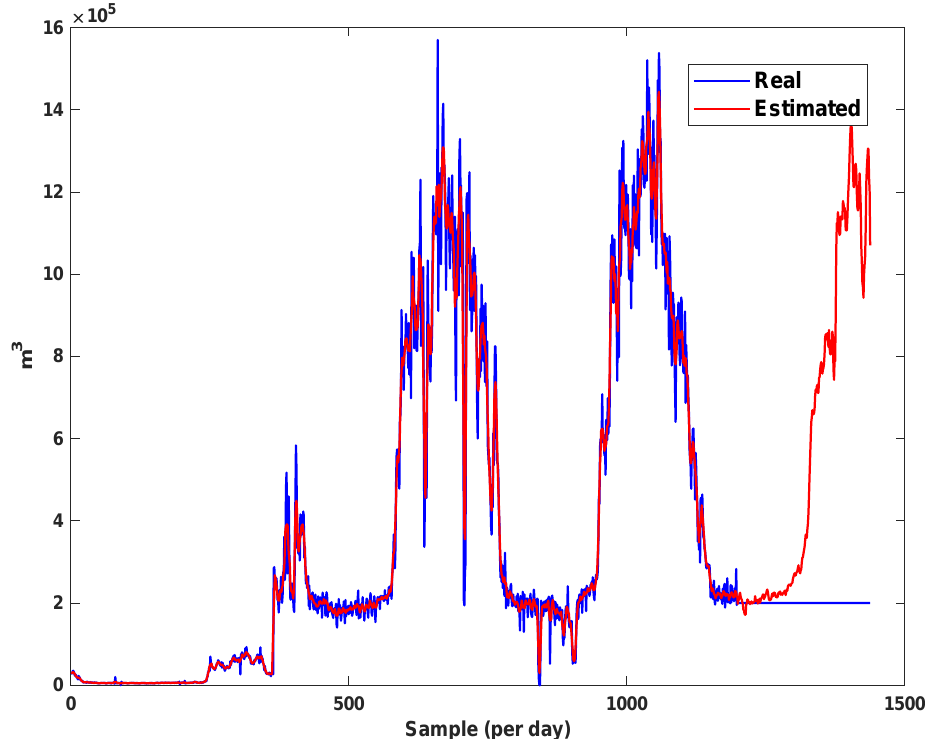
Figure 19. Detection fault 1: Total